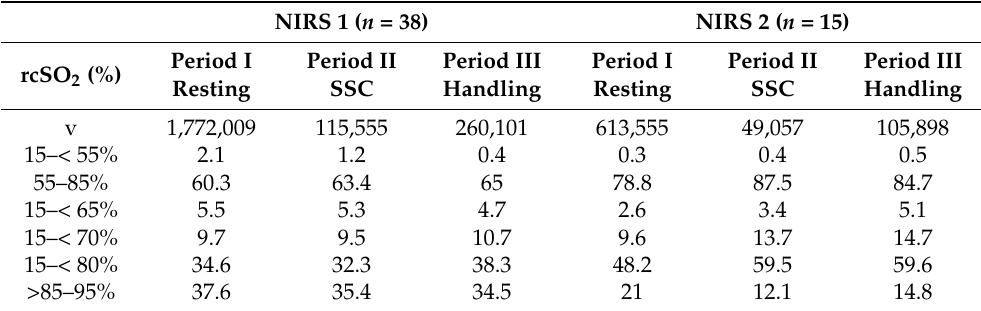
Table 4. rcSO 2 according to different thresholds including hypoxia and hyperoxia during period I (resting), period II (skin-to-skin-contact; SSC) and period III (handling) for infants with SSC. NIRS 1 ( n = 38) NIRS 2 ( n = 15) Period I Period II Period III Period I Period II Period III rcSO 2 (%) Resting SSC Handling Resting SSC Handling v 1,772,009 115,555 260,101 613,555